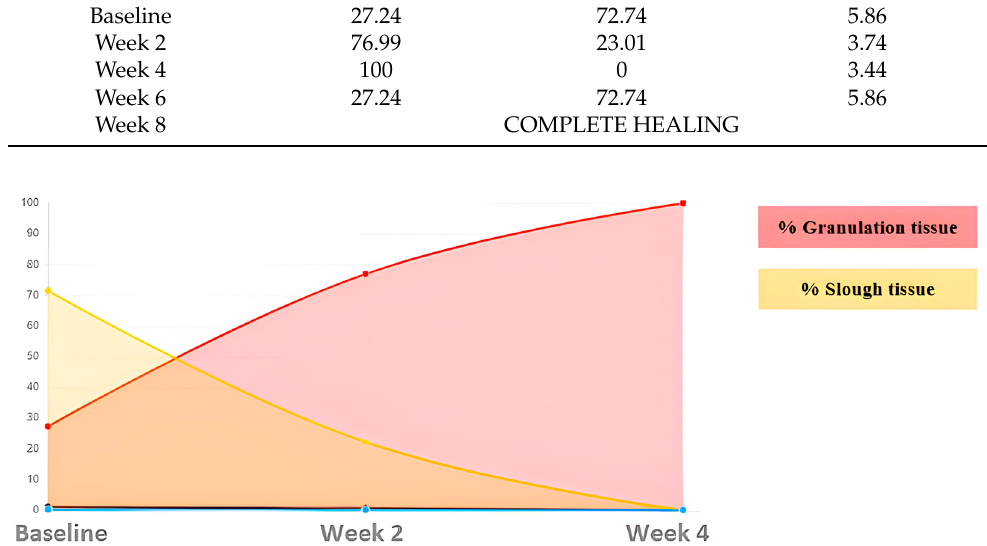
Figure 2. Evolution of tissue types. Case 1.